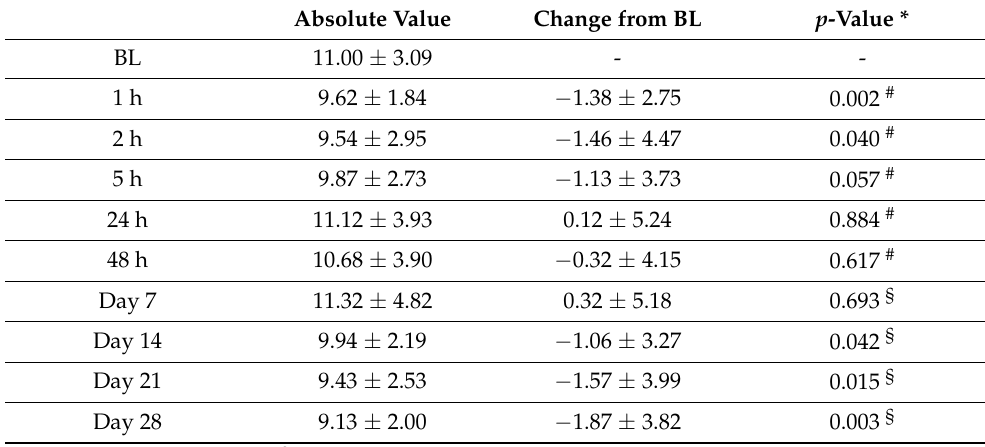
N = 42. Data are given in g/m 2 /h. The values were assessed in area A1 (= treated with Emollient 1) and are presented as mean ± SD. BL = Baseline TEWL value before first product application; h = hour. * For mean change from baseline, paired t -test. # Significant if p < 0.01 (Bonferroni correction). § Significant if p < 0.0125 (Bonferroni correction). Note: A reduction in TEWL reflects improvement in skin barrier